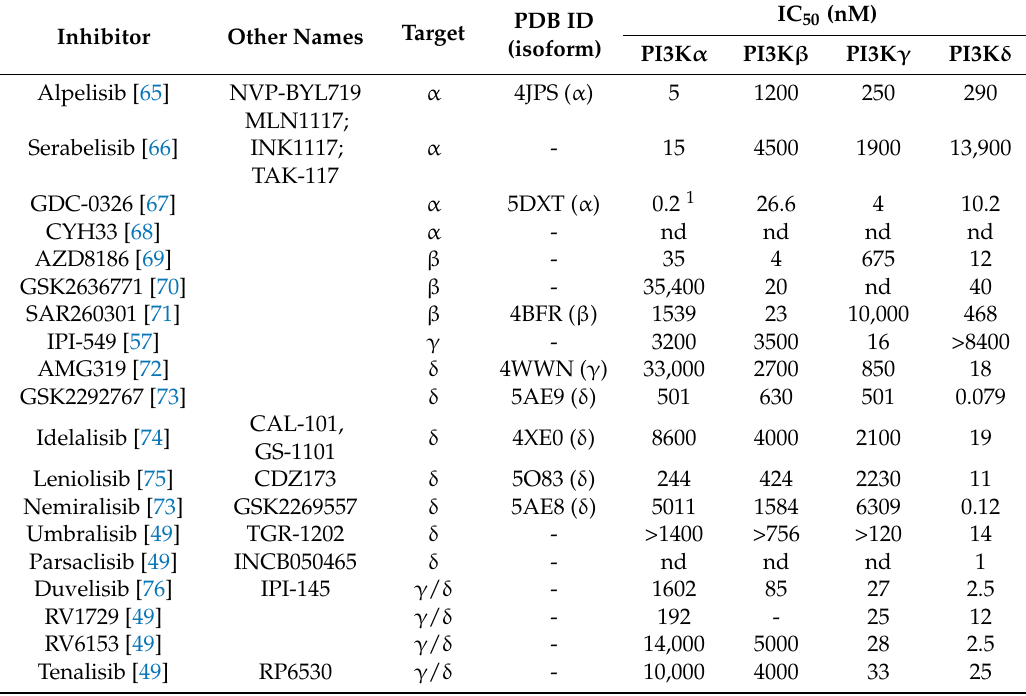
Table 1. Single and dual-isoform selective phosphatidylinositol 3-kinase (PI3K) inhibitors approved for use or under clinical